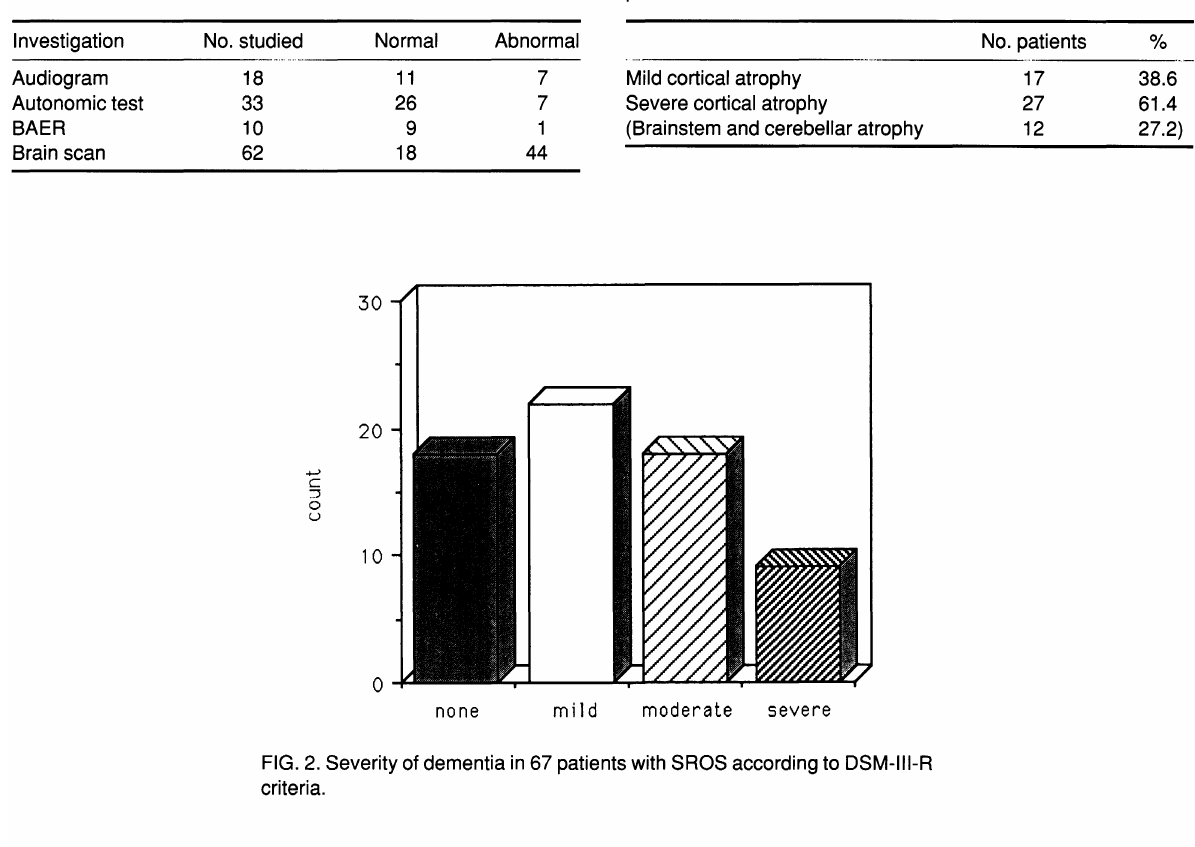
TABLE III. Results of investigation of 67 patients diagnosed as TABLE IV. Severity and type of brain scan abnormality in 44